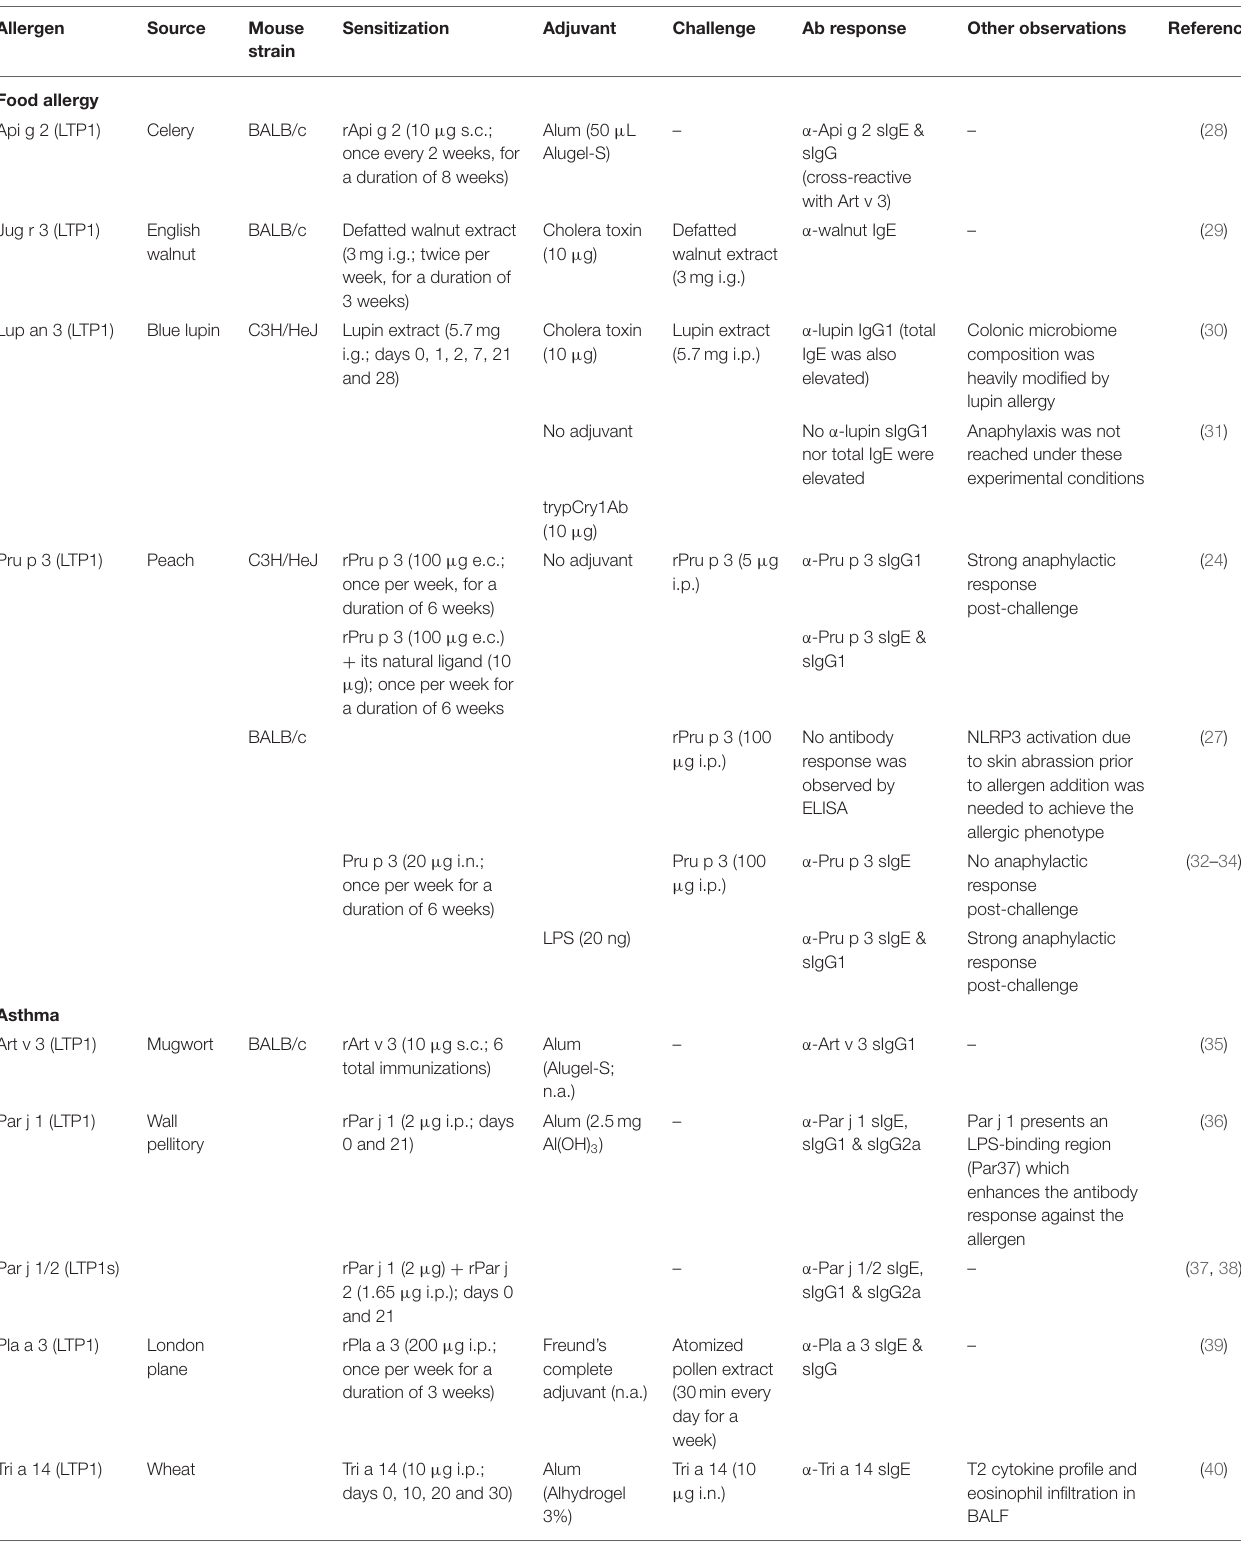
TABLE 1 | Murine models of sensitization to